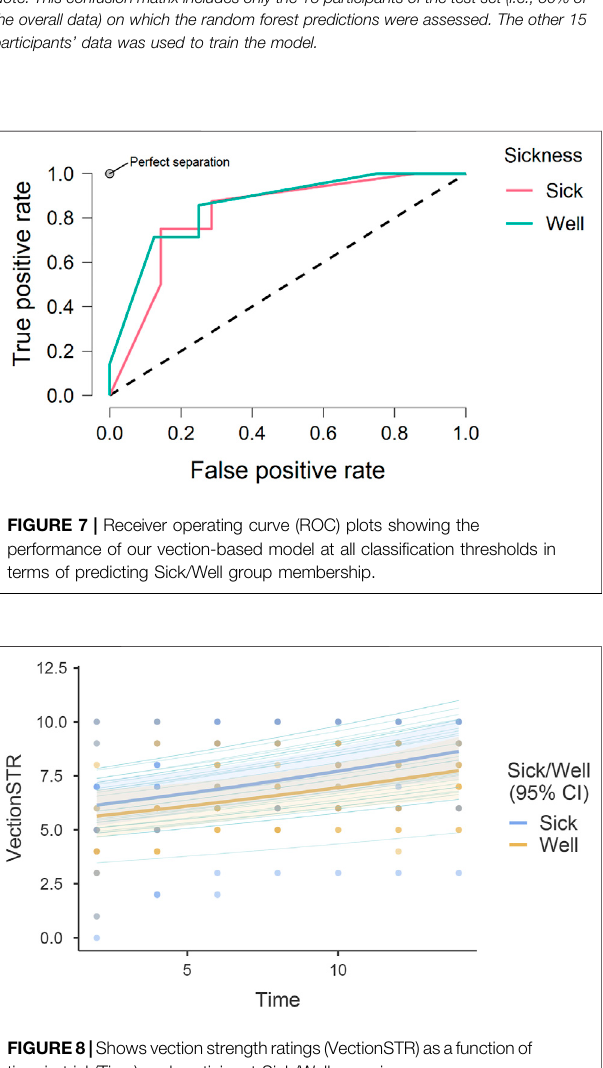
Frontiers in Virtual Reality |